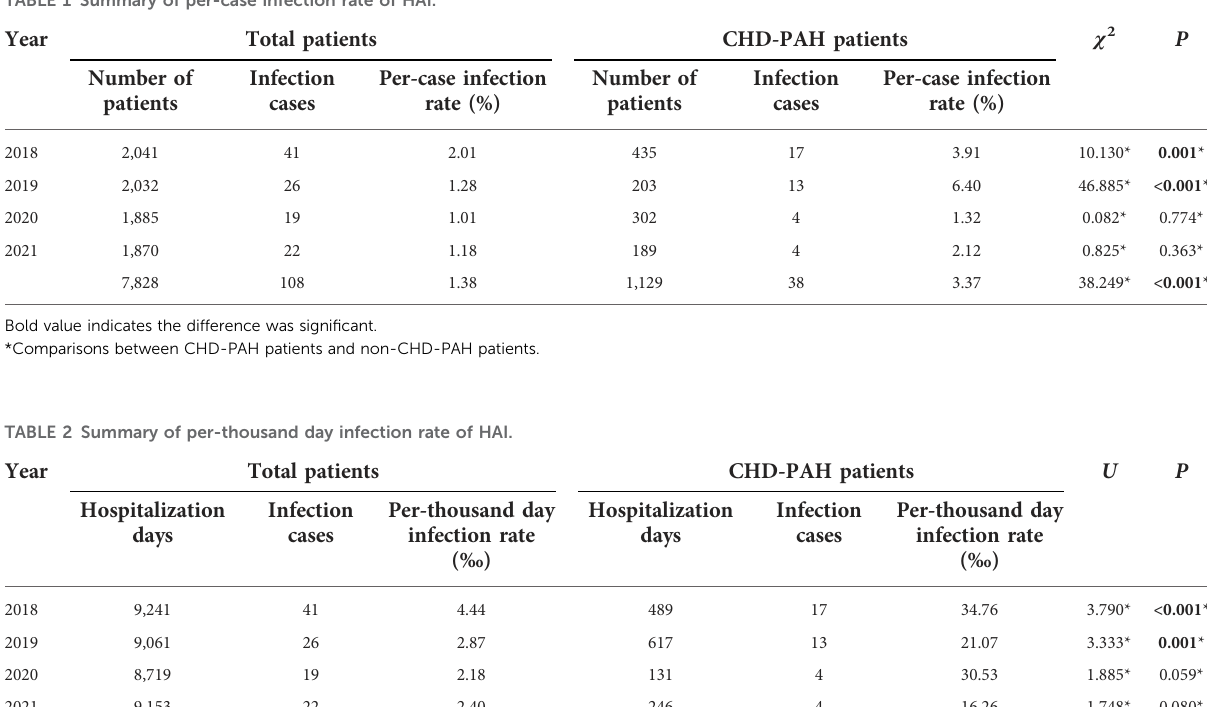
TABLE 1 Summary of per-case infection rate of HAI.